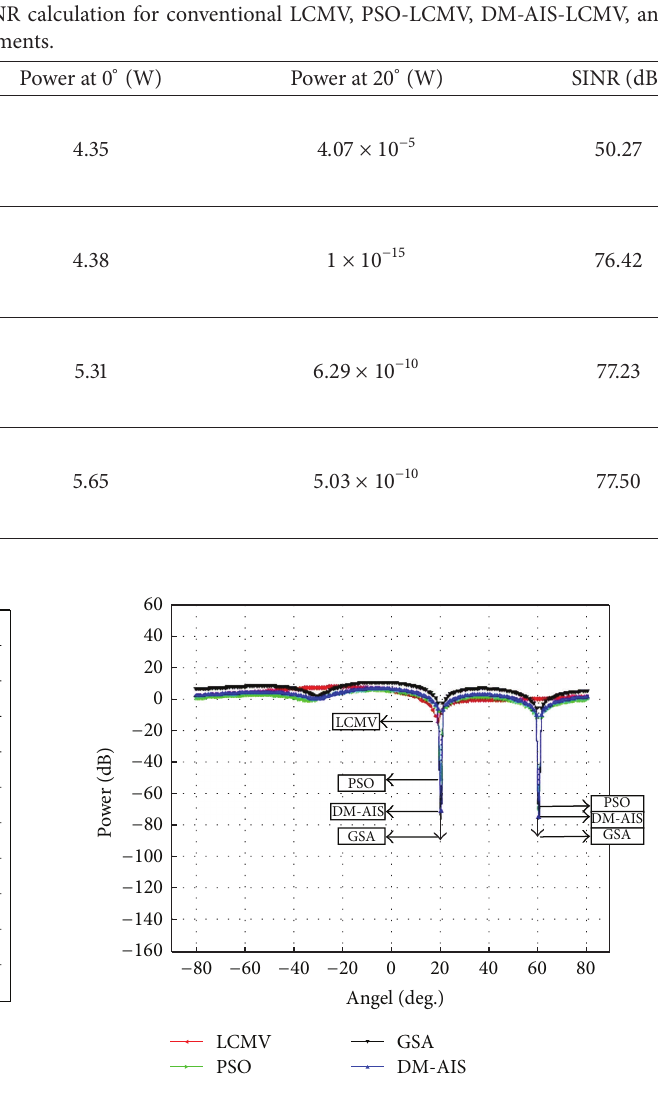
Figure 2: Comparison of performance of power response LCMV, PSO-LCMV, DM-AIS-LCMV, and GSA-LCMV for user at 0 ∘ with interference at 20 ∘ and 60 ∘ by using 4